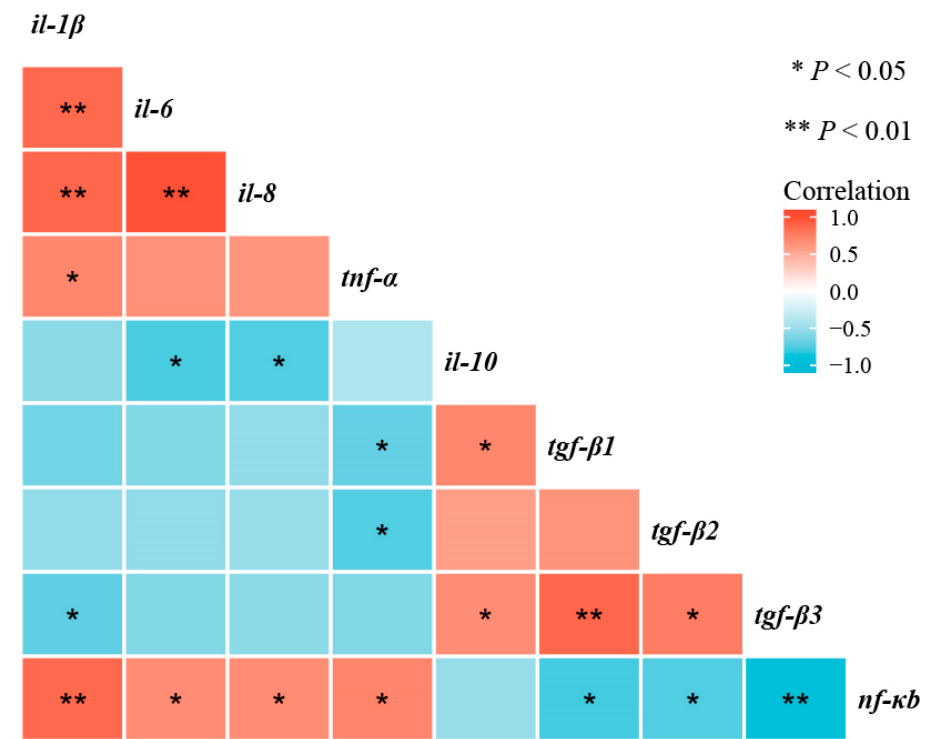
Figure 8. Correlative analysis of intestinal immune-barrier-related gene expression was performed using the R Programming Language. * p < 0.05, ** p < 0.01.